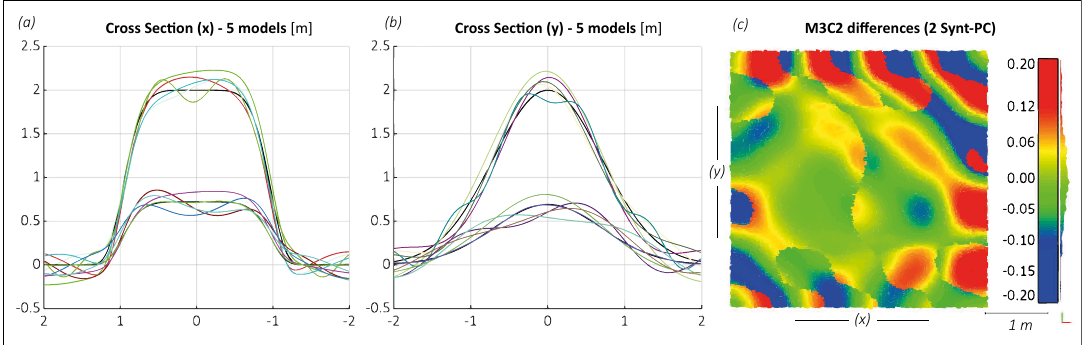
Figure 3. ( a ) X cross-sections of 5 Synt-PC (each color corresponds to a di ff erent Synt-PC), the black line corresponds to the sections of the Ref-PC. ( b ) Y cross-sections of 5 Synt-PC (each color corresponds to a di ff erent Synt-PC), the black line corresponds to the sections of the Ref-PC. ( c ) Distribution of di ff erences between two Synt-PC computed by